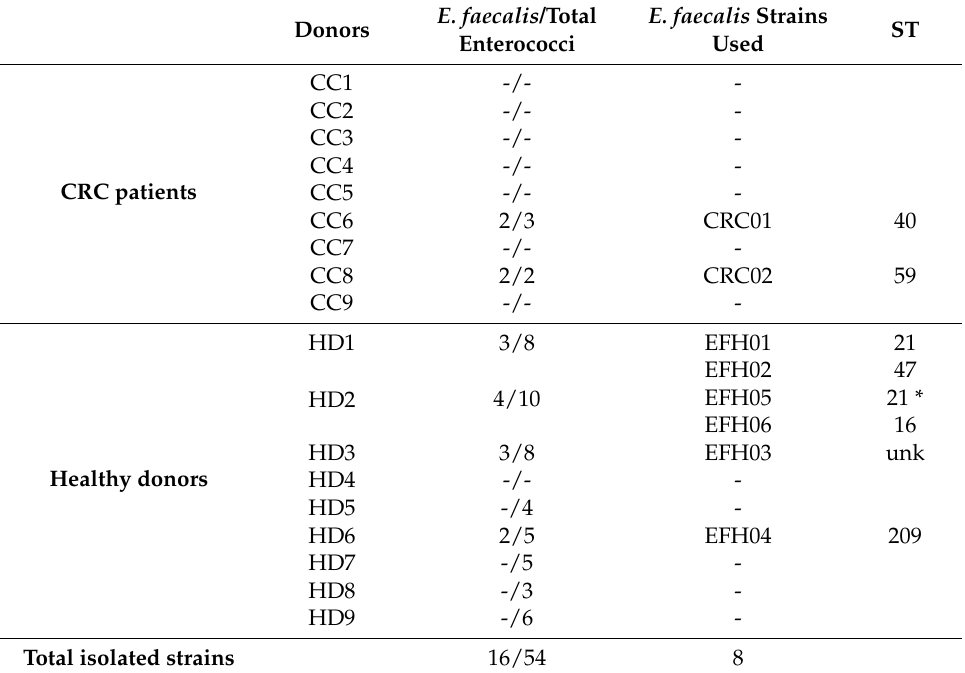
Table 3. Isolated colonies of E. faecalis and characterized strains used for experimental protocols.